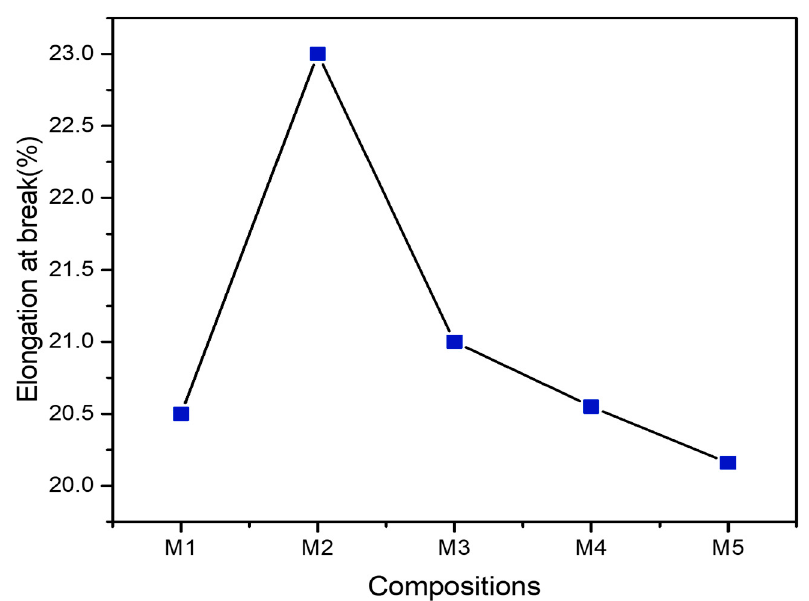
Figure 8. Elongation at break(mm) of PLA, PLA-PBS, and PLA-PBS-MCC composite films